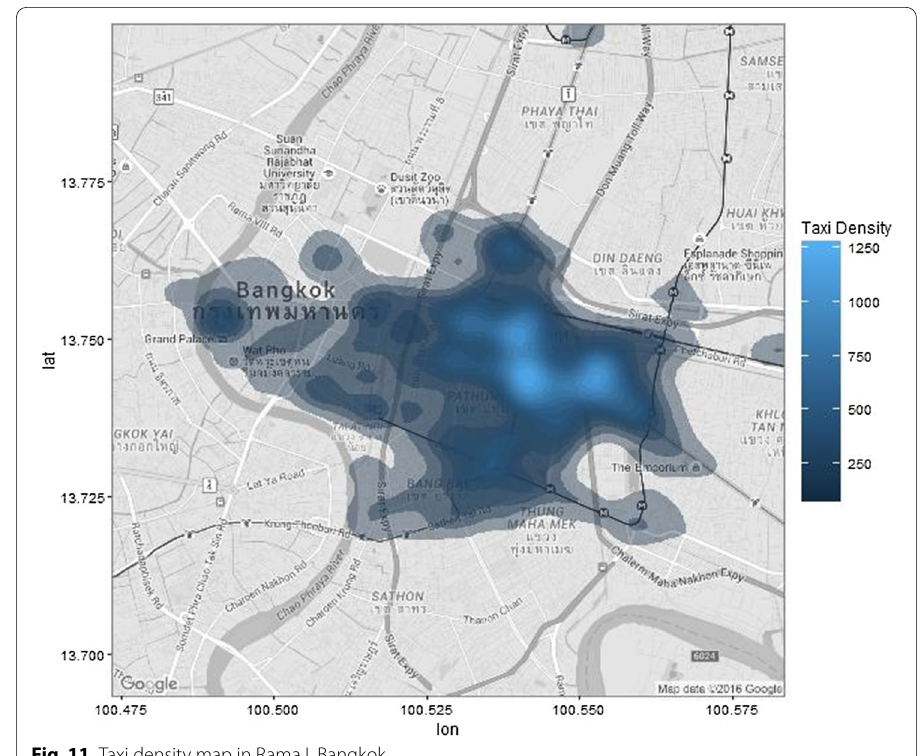
Fig. 11 Taxi density map in Rama I, Bangkok